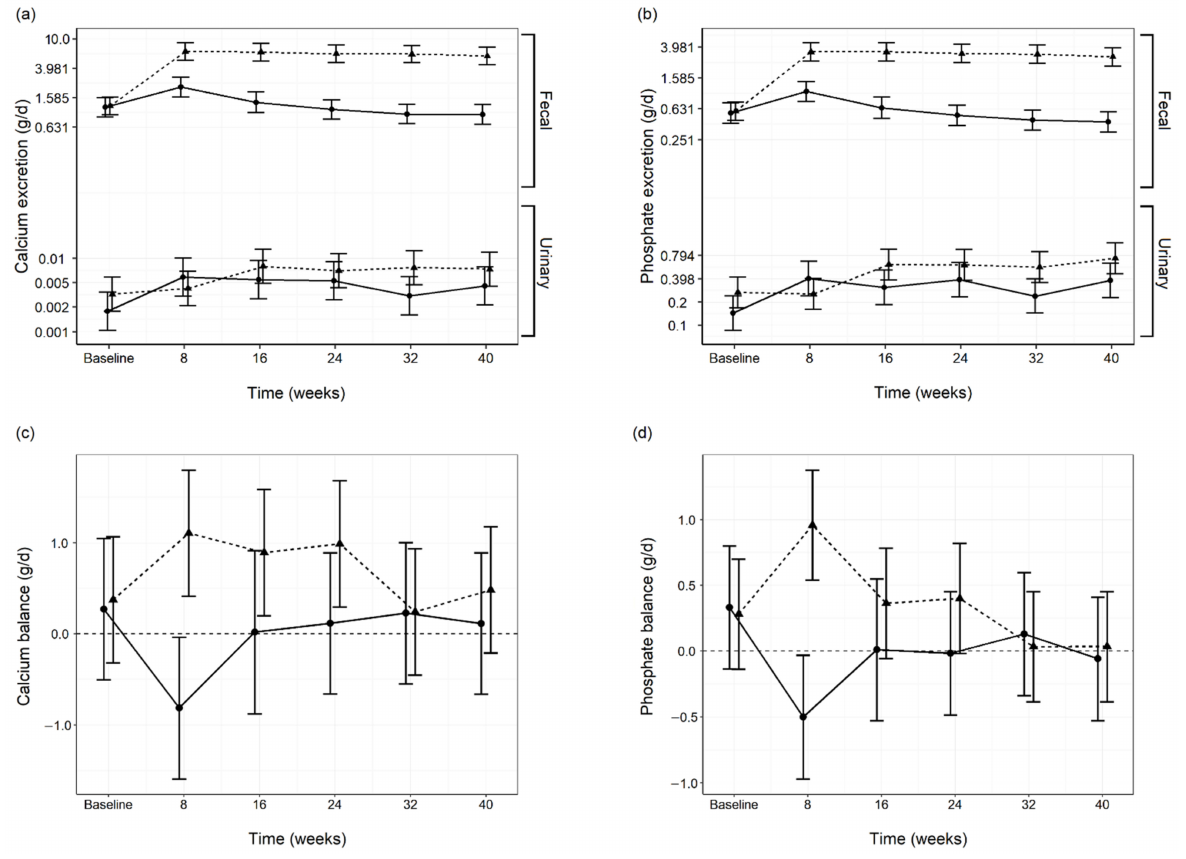
Figure 2. Fecal and urinary calcium (Ca) excretion ( a ), fecal and urinary phosphate excretion ( b ), Ca balance ( c ) and phosphate balance ( d ) throughout the study in both the control ( n = 6–8; — • —) and test (n = 10; — (cid:78) —) diet groups. Data values are presented as means and 95% confidence intervals per diet group per time